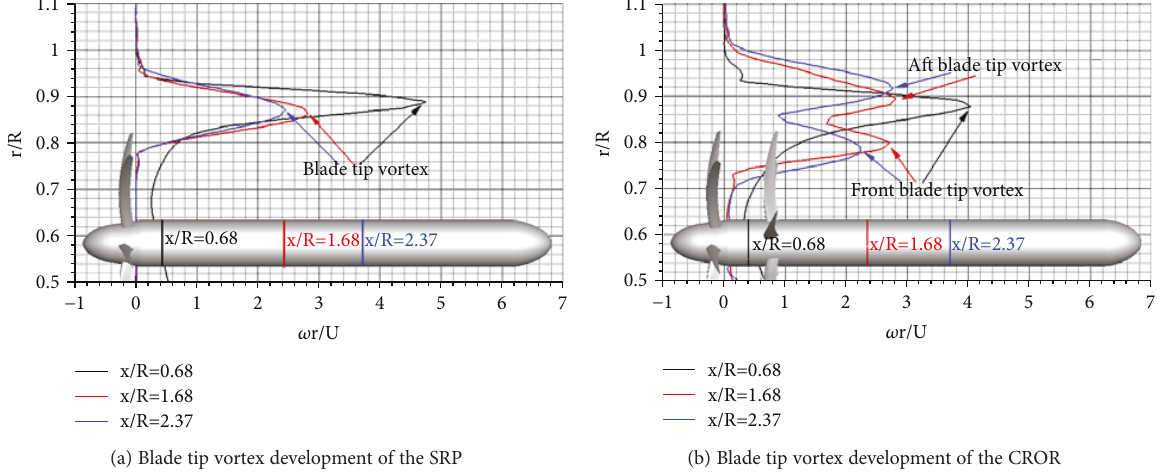
Figure 12: Blade tip vortex development at axial positions of x / R = 0 68 , x / R = 1 68 , and x / R = 2 37 .